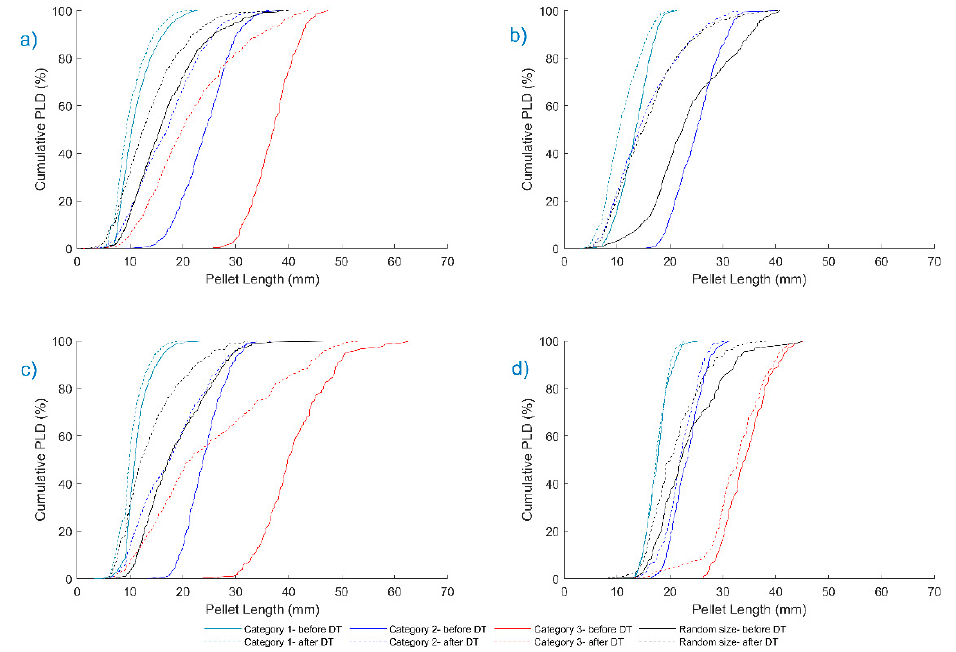
Figure 6. Pellet length distributions before and after mechanical durability tests for ( a ) torrefied mixed wood, ( b ) raw miscanthus, ( c ) torrefied poplar, and ( d ) sawdust pellets (DT: Durability test). Table 2. Mean pellet length (L 50 ) and the number of pellets before and after mechanical durability test. L 50 (mm) Sample PLD